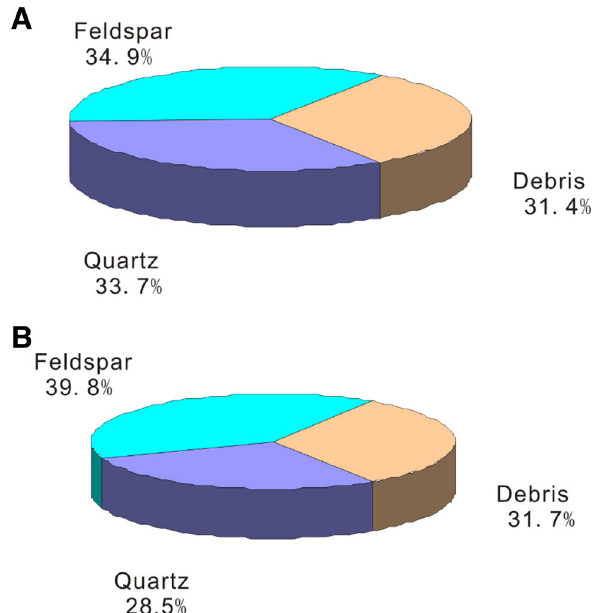
Fig. 3 Reservoir petrologic characteristics of the study area. a pet- rologic characteristics of CPEDC3; b petrologic characteristics of